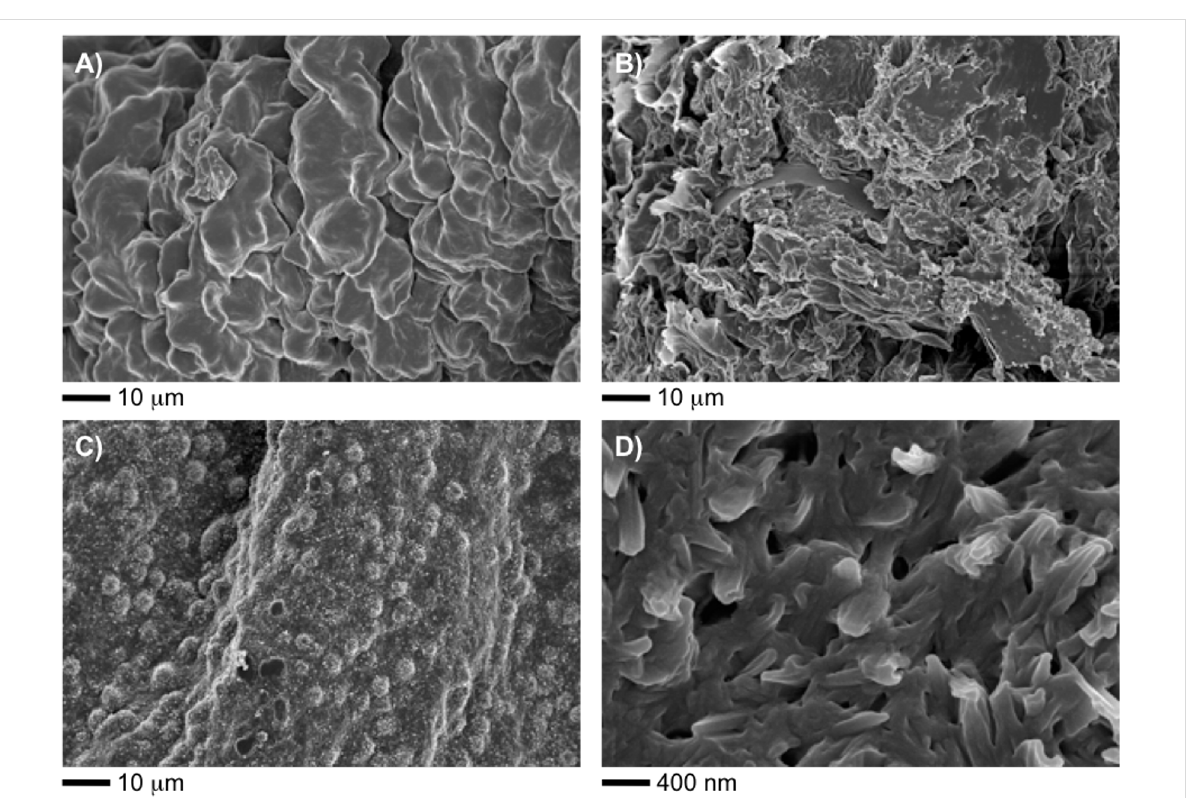
Figure 4: Representative FESEM images of selected xerogels prepared by freeze-drying the corresponding organogels made of 3 in (A) ethyl acetate ( c = 36 g/L), (B) methanol ( c = 47 g/L), (C and D) butan-1-ol ( c = 56